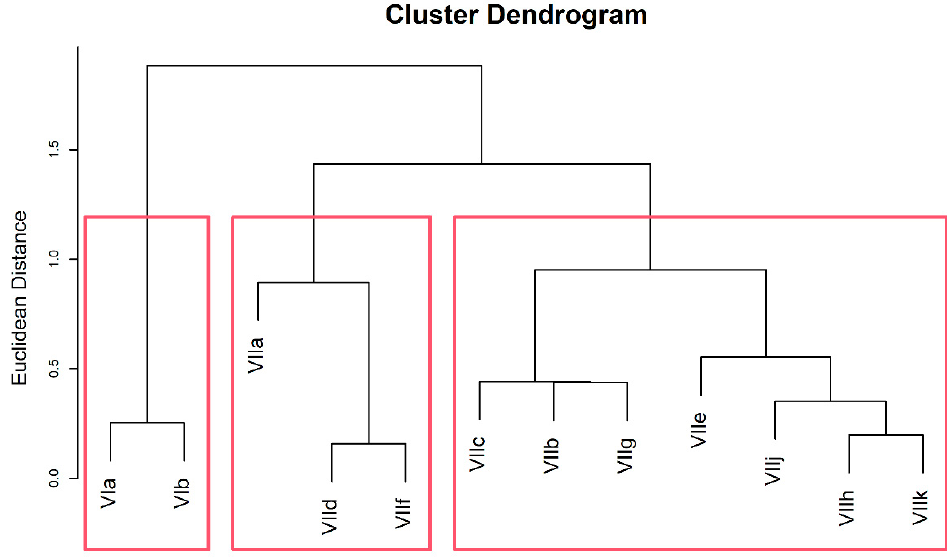
Figure 9. Cluster groups of ICES divisions considering Chl-a, K490, and SST